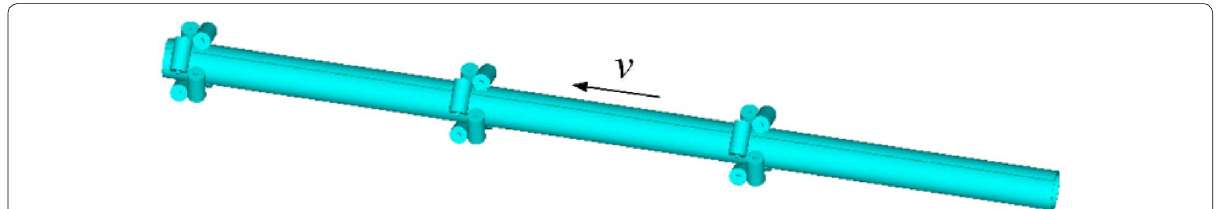
Figure 2 The dynamic model of